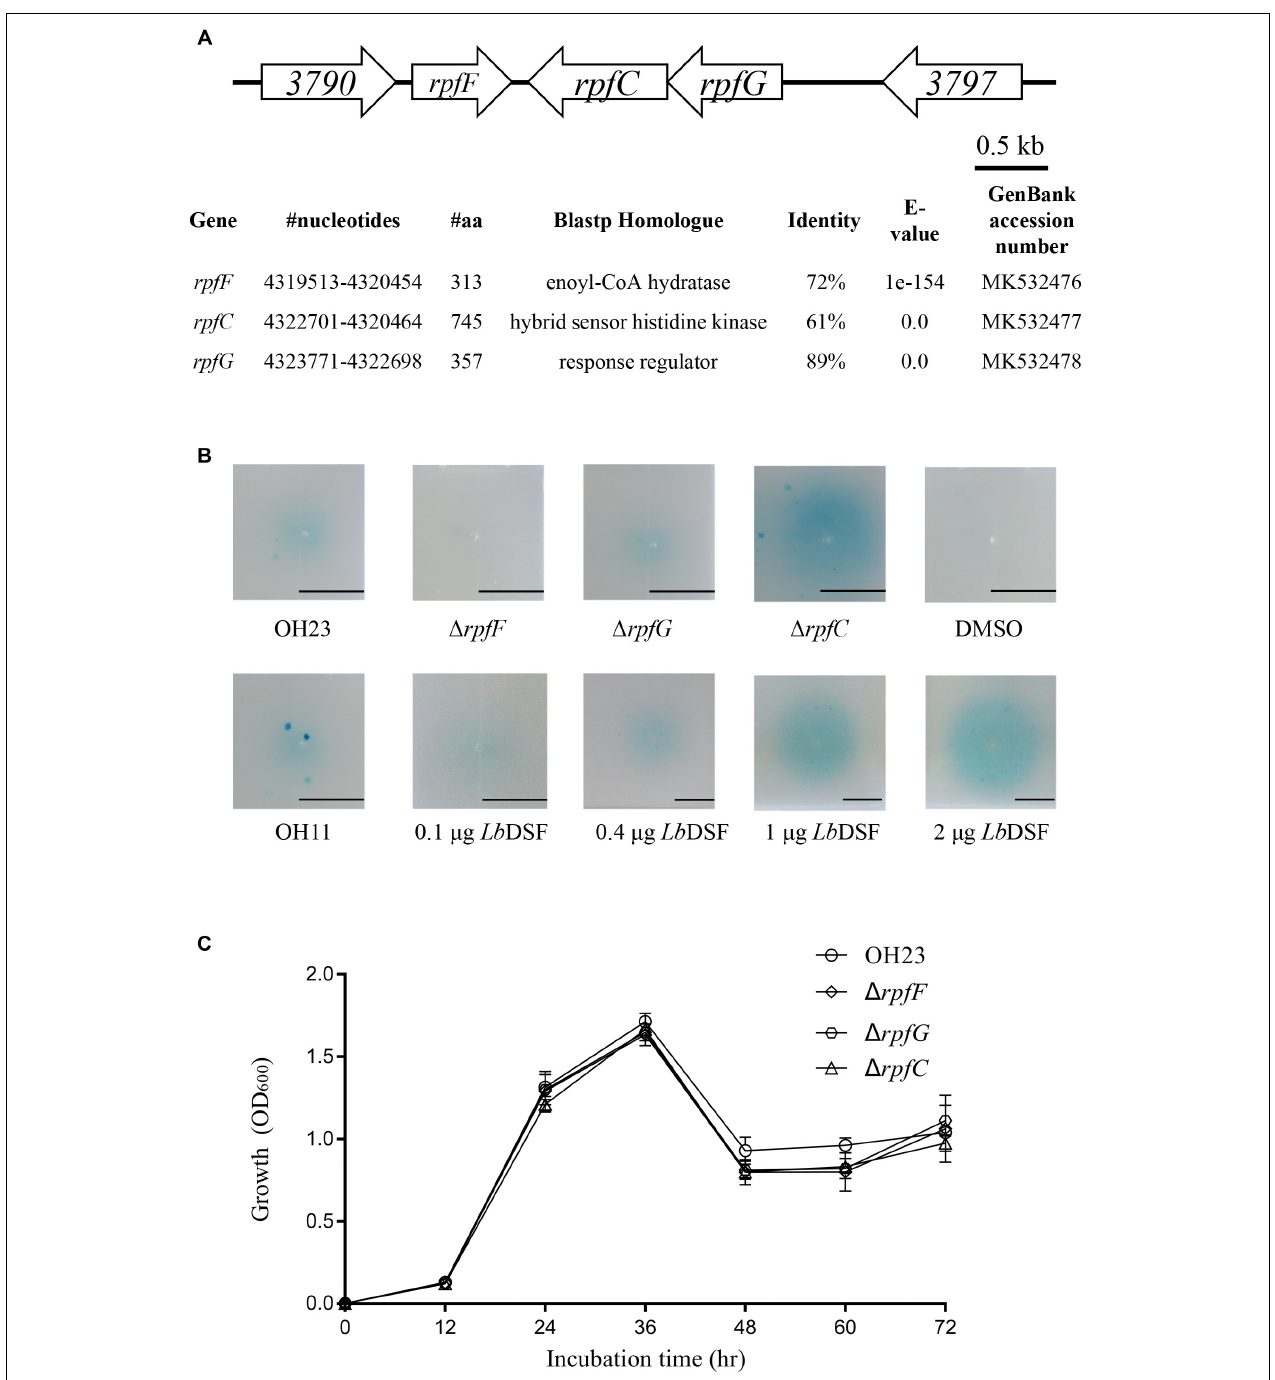
FIGURE 2 | Location of the rpf genes in the genome of L. brunescens OH23 and the DSF activity of the different L. brunescens OH23, rpf mutants, or L. enzymogenes OH11. (A) BLASTp comparison between the proteins encoded by the rpf genes ( rpfF , rpfC , and rpfG ) of L. brunescens and L. enzymogenes . The protein similarity was compared using BioEdit7.0.9.0. (B) The DSF production ability of strain OH23 and its corresponding rpf mutants. (C) The growth of wild-type OH23 and its corresponding rpf